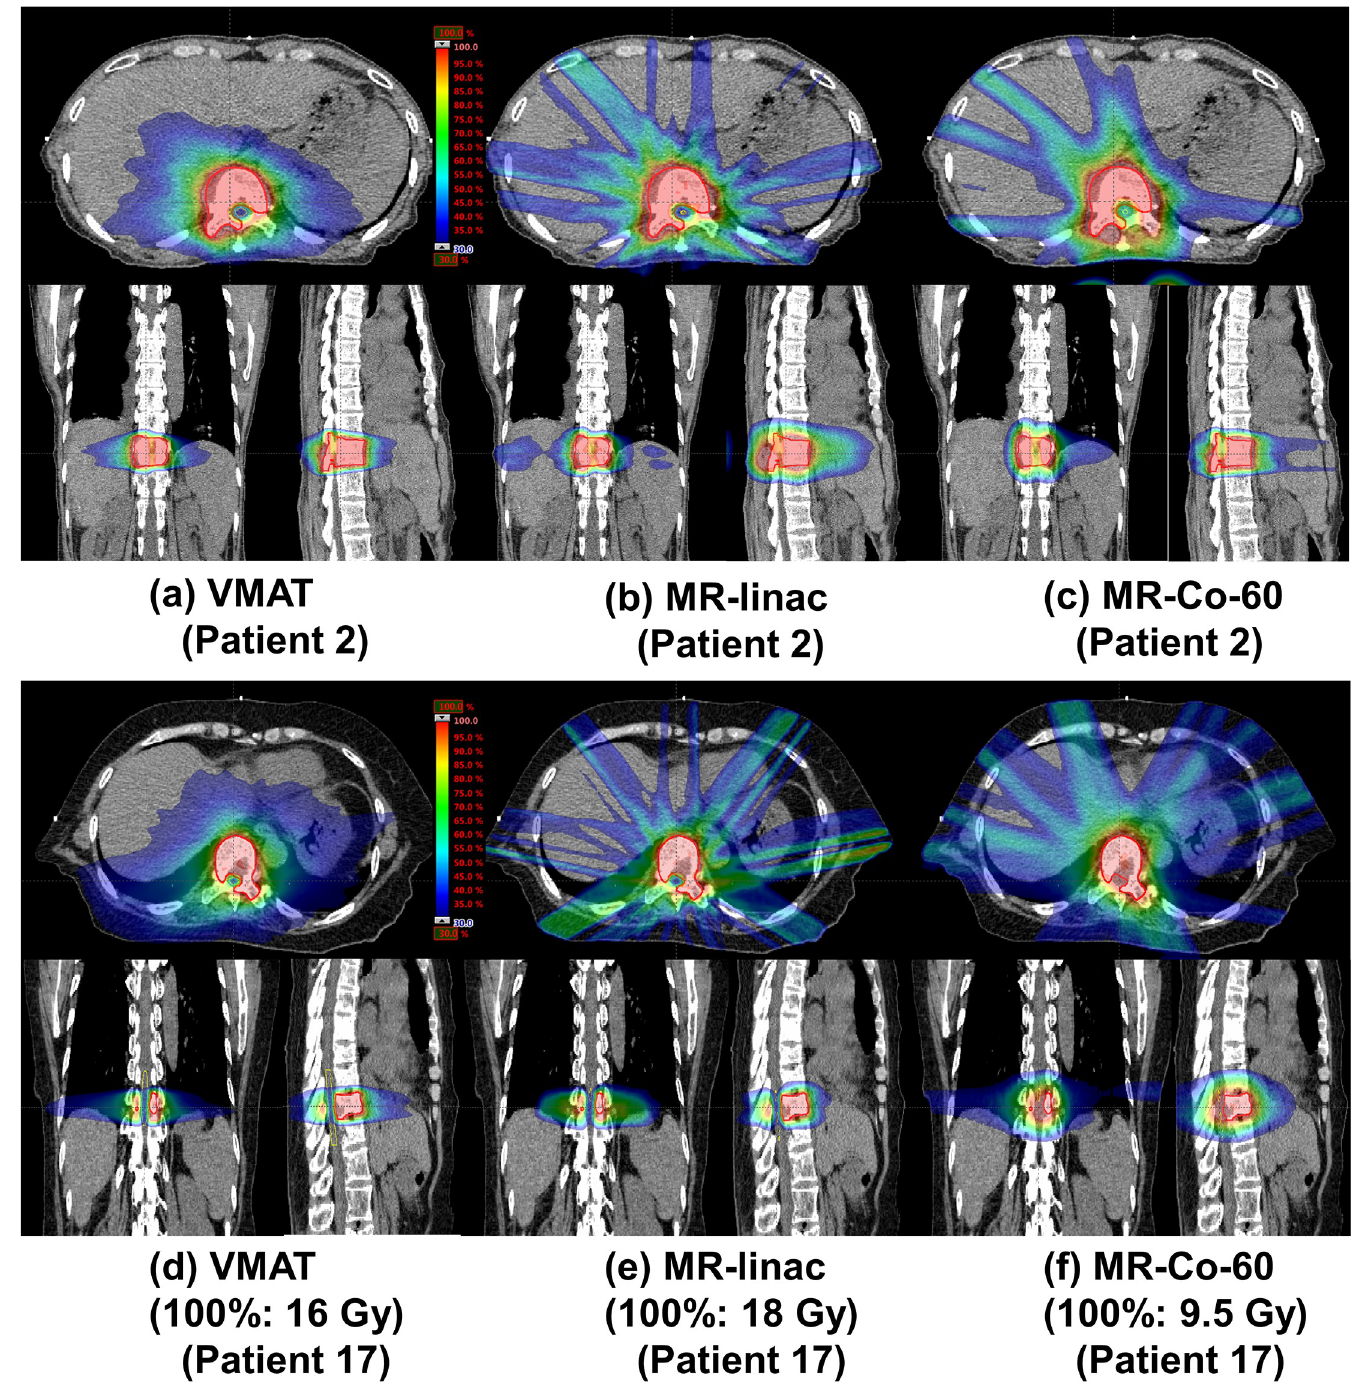
Fig 1. Dose distributions of the volumetric modulated arc therapy (VMAT) plans, intensity modulated radiation therapy (IMRT) plans with the MRIdian Linac system (MR-linac), and IMRT plans with the ViewRay system (MR-Co-60) of two representative cases for spine stereotactic ablative radiotherapy (SABR). One (patient No. 2) is a representative case with a prescription dose of 18 Gy for VMAT (a), MR-linac IMRT (b), and MR-Co-60 IMRT plans (c). The other (patient No. 17) is a representative case with prescription doses of 16 Gy, 18 Gy and 9.5 Gy for VMAT (d), MR-linac IMRT (e), and MR-Co-60 IMRT plans (f), respectively.